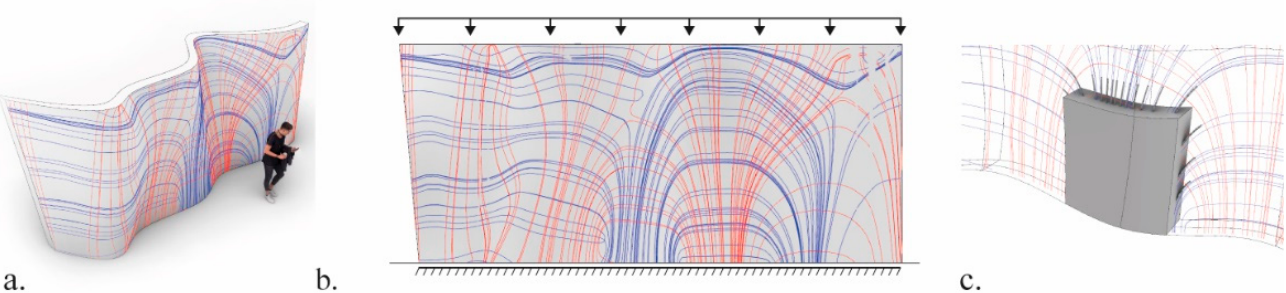
Figure 3. ( a ) prototypical free form wall as part of a building ( b ) assigned loads and supports to curved wall and visualised force-flow. Encased WAAM structure in stress visualisation ( c ) selected section to manufacture with WAAM.